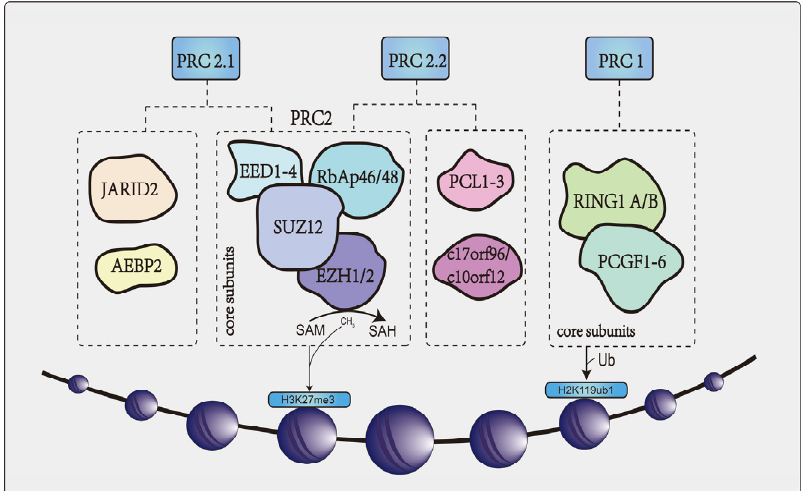
Figure 1. The core structure of PRCs, including PRC1 and PRC2. PRC1 complexes are E3 ubiquitin ligases that monoubiquitinate lysine 119 of histone H2A (H2AK119ub1), consisting mainly of two core subunits. PRC2 consists of four major core subunits and binds to different non-core subunits divided into PRC2.1 and PRC2.2. PRC2 catalyzes the monomethylation, dimethylation, and trimethylation of lysine 27 on histone H3 (H3K27me1, H3K27me2, and H3K27me3). SAM provides the methyl group for the reaction catalyzed by histone methyltransferase.